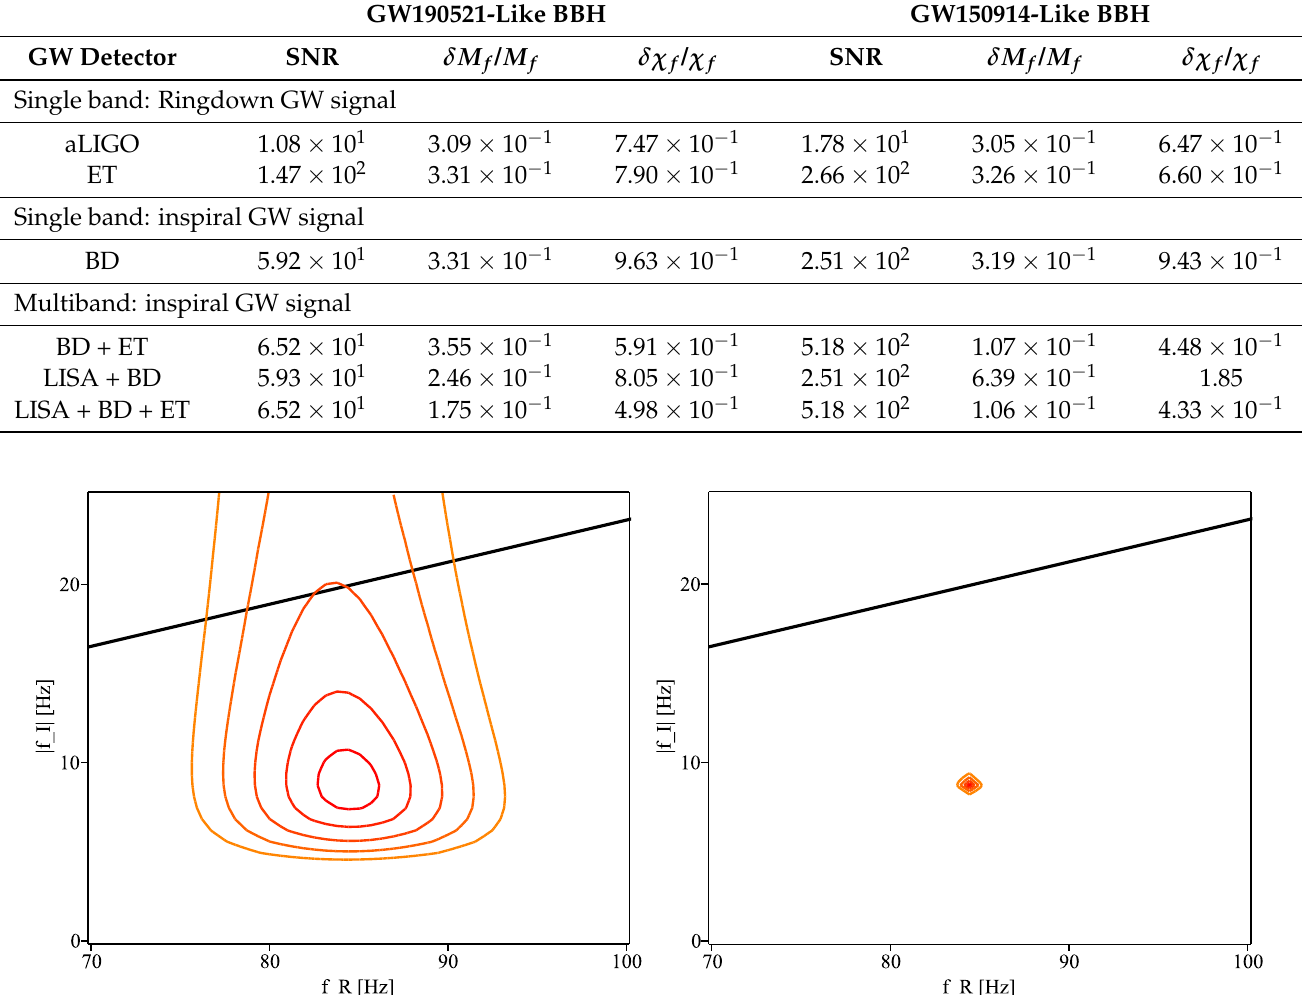
Table 4. Parameter estimation errors of the remnant mass and spin of GW190521-like and GW150914-like BBH systems, using only the ringdown GW signal as well as the inspiral GW signal inferred via the NR remnant fitting formulas; the best fit values are ( M f / m , χ f ) ∼ ( 0.904, 0.883 ) for the GW190521-like BBH (recall Equation (27)) and ( M f / m , χ f ) ∼ ( 0.891, 0.898 ) for the GW150914-like BBH. Here, BD is an abbreviation for B-DECIGO. The results in the single band are normalized to the SNR for a given GW observatory. In the multiband case, they are normalized to the total SNR of ρ LISA + BD + ET .